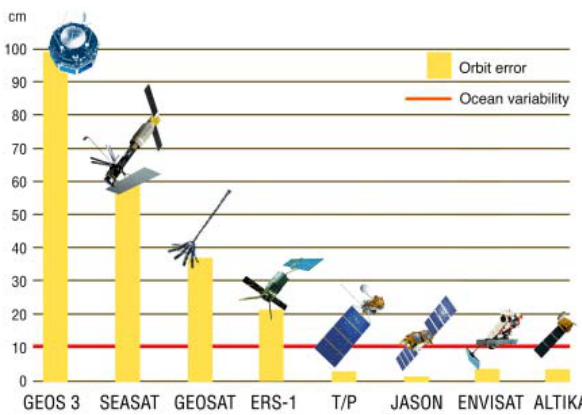
Fig. 2. Evolution of accuracy of altimeter missions.